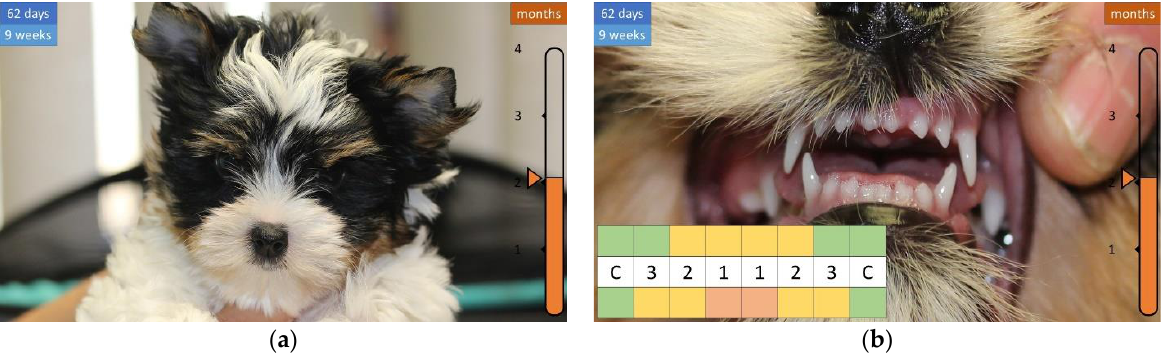
Figure 8. Development of the skull and teeth in a 2-month-old puppy. ( a ) More articulated head. ( b ) Most of the incisors are clearly visible.